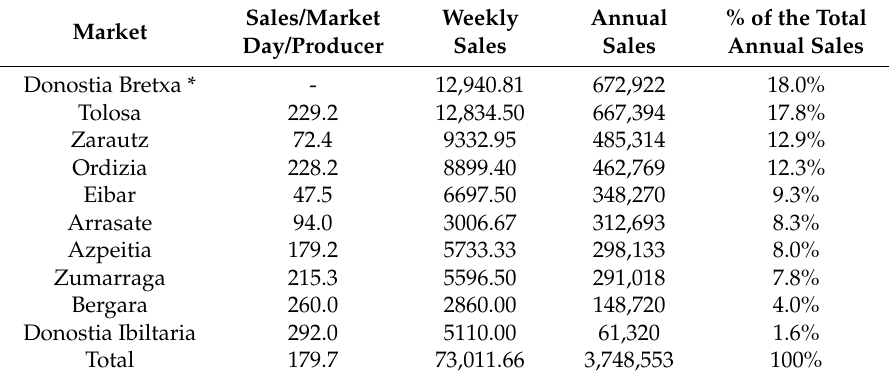
Table 3. Sales in markets according to producers (in